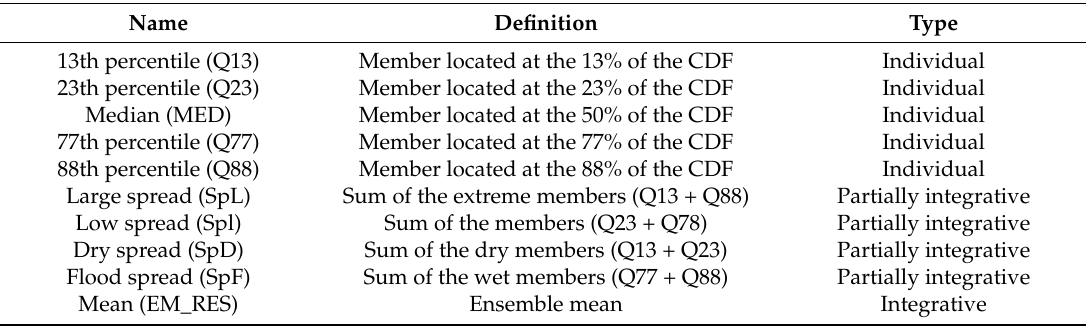
Table A2. Methods to detect drought events from the S4 ensemble system. Adapted from